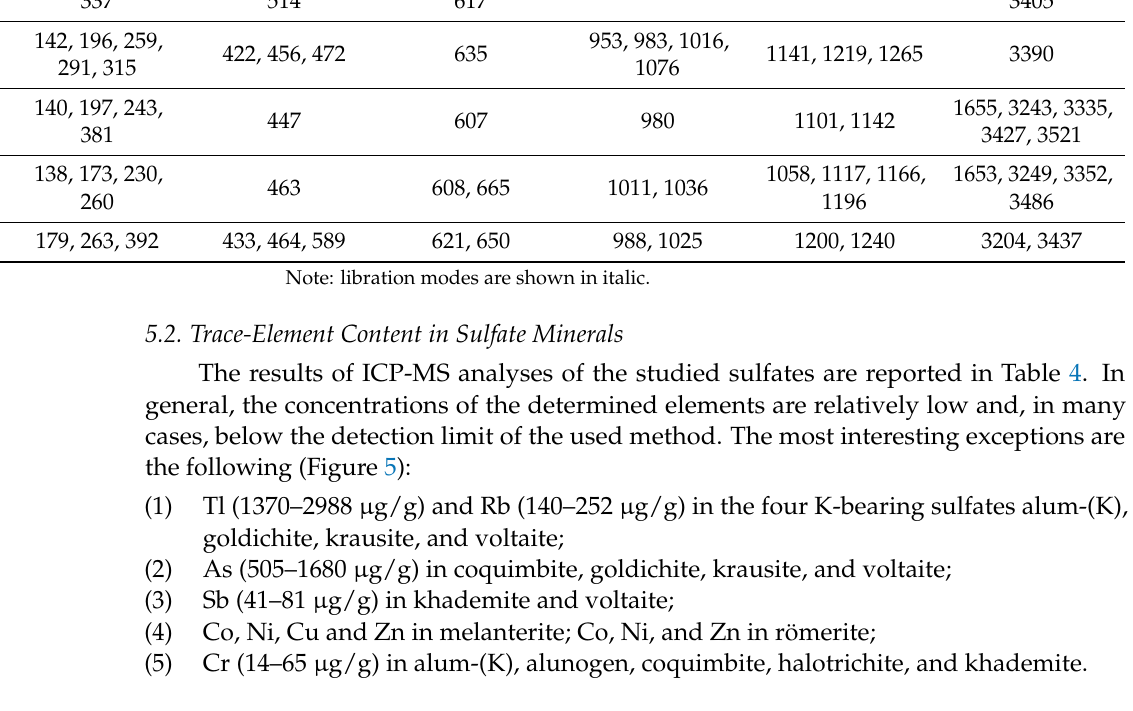
Table 4. ICP-MS analyses (in µ g/g) of the studied